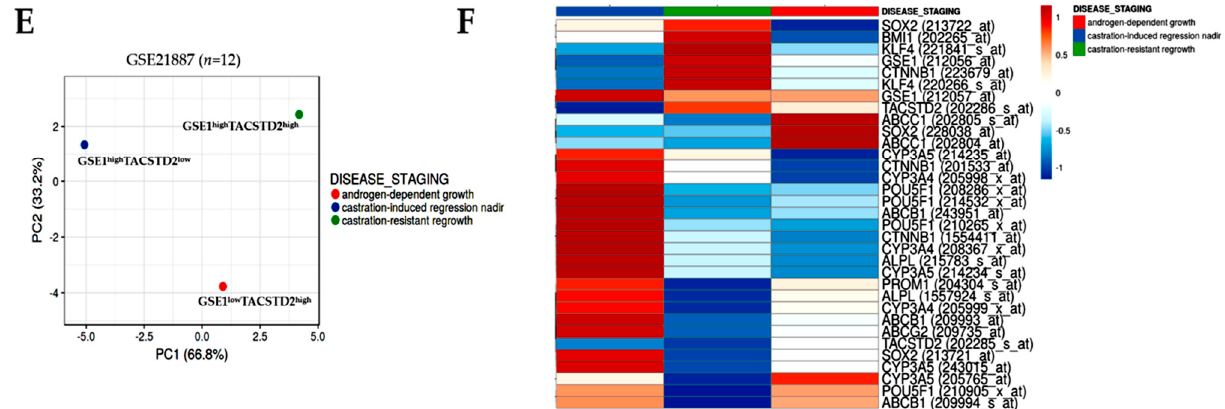
Figure 5. GSE1 and TACSTD2 expression profiles are indicative of therapy responses and clinical outcomes in patients with prostate cancer. Box-and-whisker plots showing how ( A ) GSE1 or ( B ) TACSTD2 expression affects follow-up treatment success in the TCGA PRAD cohort. ( C ) Principal component analysis of the expression data for primary localized PCa vs. castration-resistant bone metastatic prostate in the GSE32265 cohort. Columns with similar annotations were collapsed by taking the mean in each group. Unit-variance scaling was applied to rows; SVD with imputation was used to calculate principal components. X- and Y-axes show Principal Components 1 and 2, which explain 52.4 and 26.9% of the total variance, respectively. N = 5 data points. ( D ) Expression heatmap showing the association between metastasis, androgen deprivation, TMPRSS2-ERG fusion gene, and expression of GSE1, TACSTD2, biomarkers of drug metabolism/resistance, and cancer stemness in the GSE32265 cohort. ( E ) Principal component analysis of the expression data for the treatment of castration-resistant prostate cancer in the GSE21887 cohort. X- and Y-axes show Principal Components 1 and 2, which explain 66.8 and 33.2% of the total variance, respectively. ( F ) Expression heatmap showing the association between disease stage and expression of GSE1, TACSTD2, biomarkers of drug metabolism/resistance, and cancer stemness in the GSE21887 cohort.